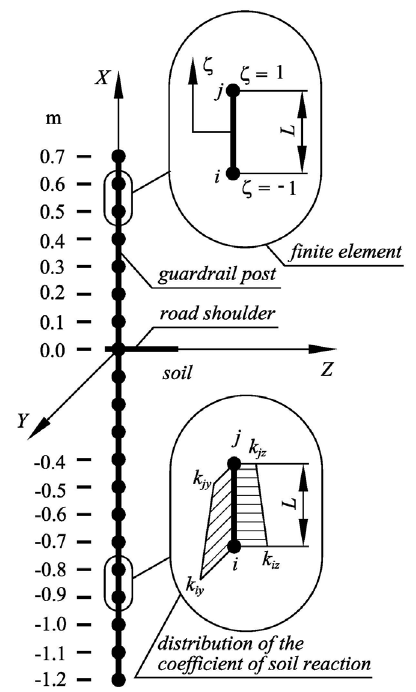
Fig. 2. A schematic view of the metal guardrail post and one- dimensional first-order finite element, and distribution of the coefficient of soil